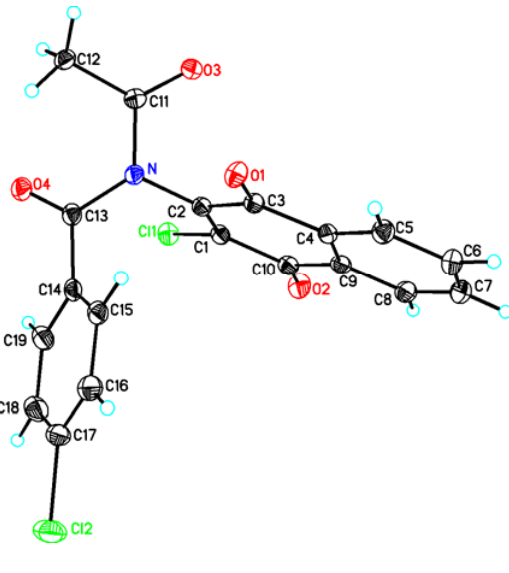
Figure 3. Molecular structure of compound 7